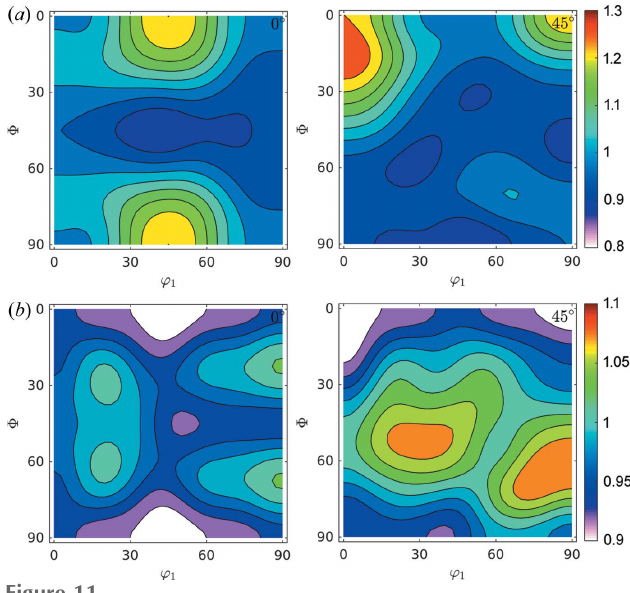
Figure 11 GDFs for ( a ) domain size and ( b ) dislocation density at ’ 2 = 0 (cid:6) and ’ 2 =